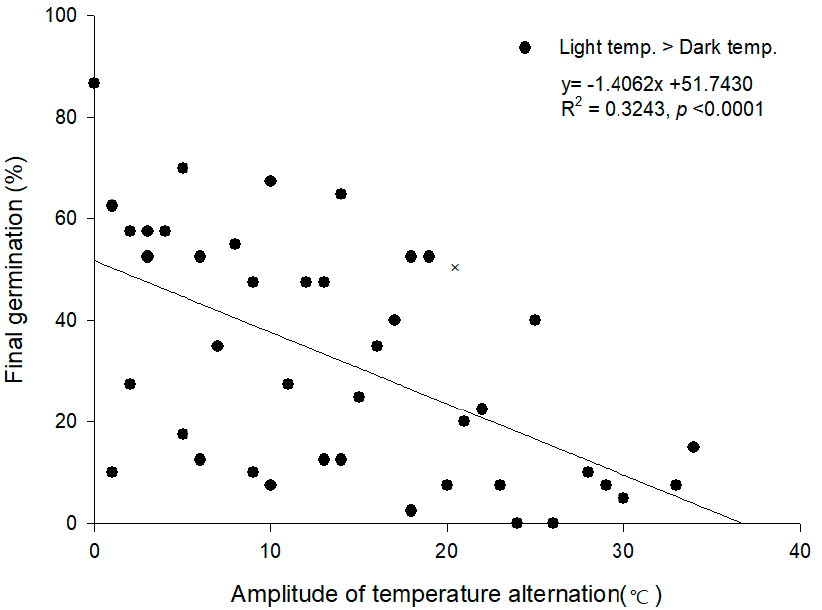
Figure 5. Relationship between the amplitude of temperature alternation (°C) and FGP (%) deter- mined using the thermal gradient plate, with the temperatures during the light period being higher than those during the dark period.